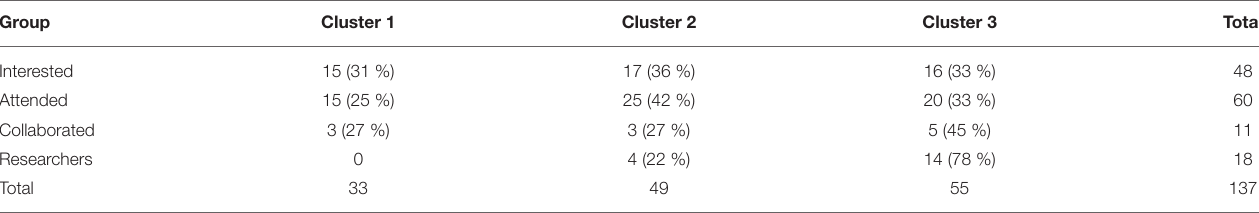
The different groups are differentially distributed among clusters. ( χ 2 = 14.83, p < 0.05). Post hoc comparison with FDR correction shows that the group Interested and group Researchers are different (p < 0.01) as well as Attended and Researchers (p < 0.01). None of the other groups show statistically significant differences in their distributions among clusters (all ps >